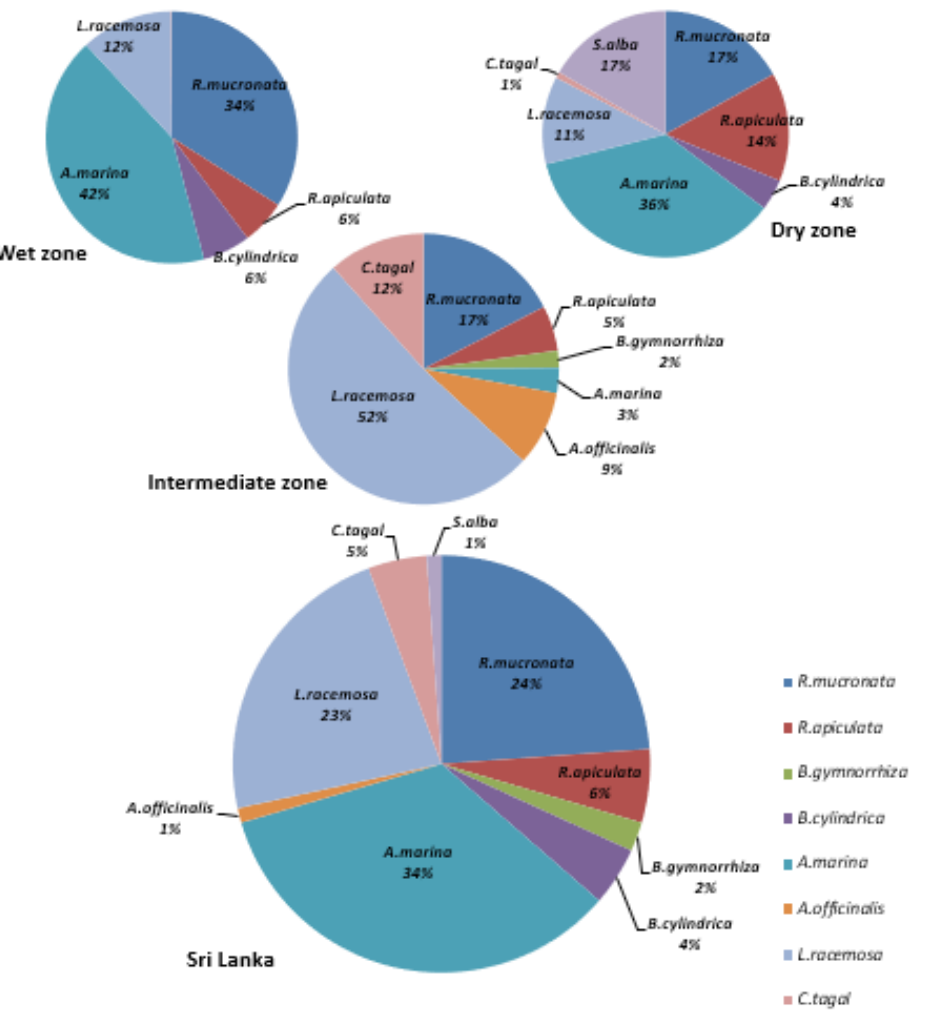
Figure 2: Distribution of mangrove species among different climatic zones of Sri